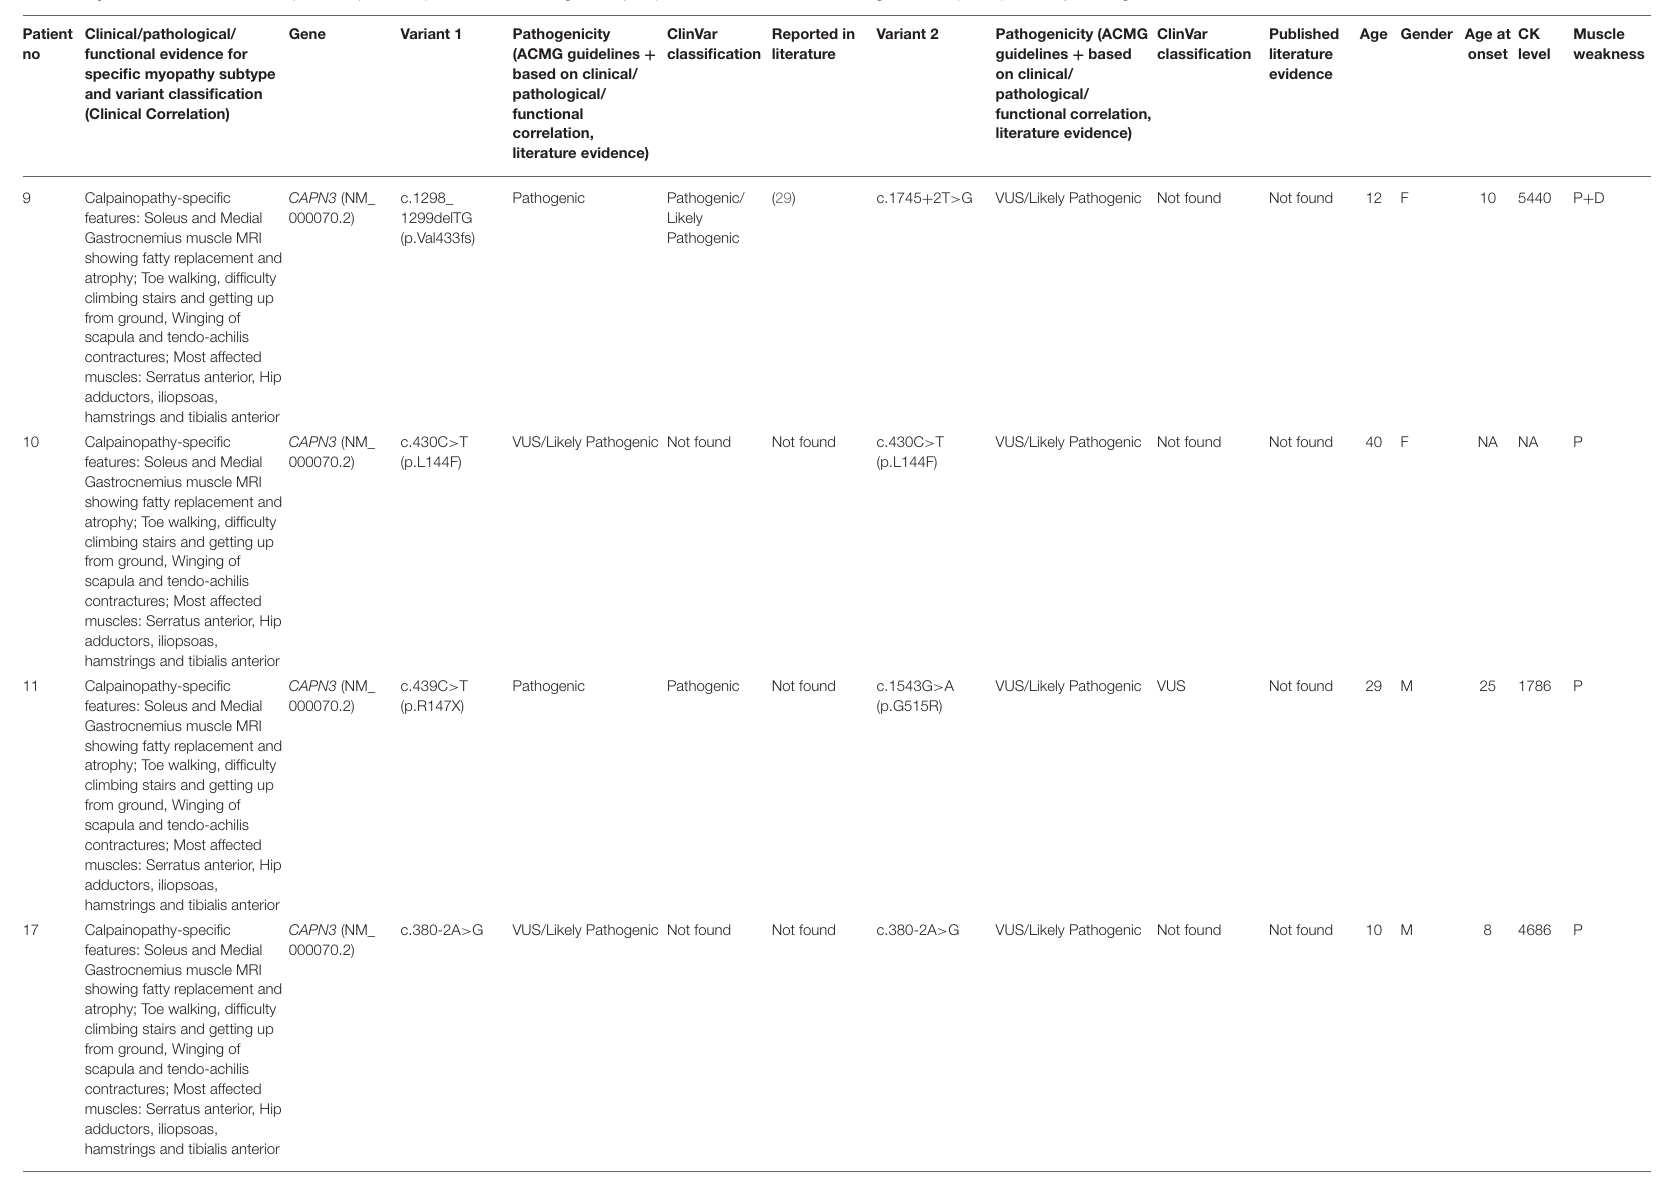
TABLE 6 | Molecular and Clinical aspects of patients (not included in diagnostic yield) with Variants of Uncertain Significance (VUSs) or Likely Pathogenic but with Clinical Correlation with Gene of interest. Patient Clinical/pathological/ no functional evidence for specific myopathy